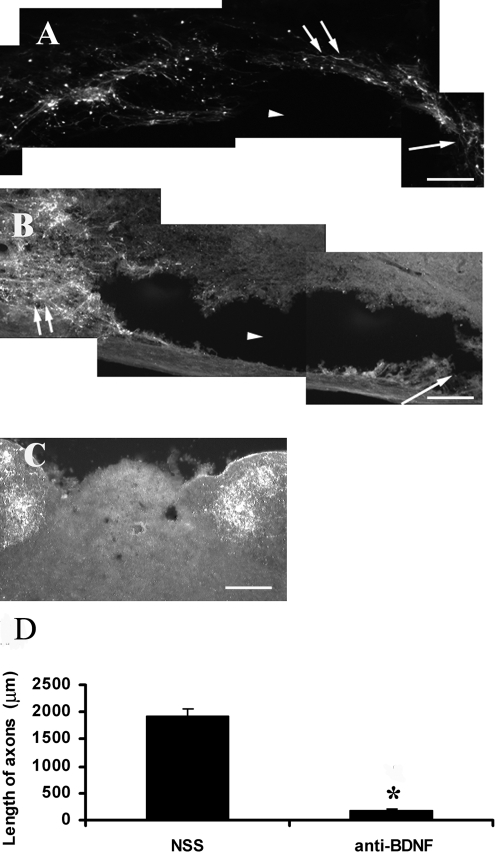
Microphotographs show CTB labeled axons within spinal dorsal column of rats after conditioning sciatic nerve lesion and spinal cord injury.Micrographs (A and B) were captured in the caudal–rostral orientation from left to right. A: In the rats of the NSS treated group, CTB labeled axons (see double arrows) in dorsal column were detected in the spinal cord central and rostral to lesion site along the wall of the cyst resulted from spinal cord injury. B: In the rats of the BDNF antiserum treated group, axons stopped caudal to lesion site (see double arrows) and failed to regenerate into the cyst (see arrow). C: In the rats without spinal cord injury, CTB was transported transganglionically along dorsal column to label the terminals in the gracile nucleus. D: The measurement of the length of CTB positive axons detected beyond the caudal edge of the cysts. The enhanced axonal regeneration by sciatic nerve lesion was substantially blocked by the treatment of the BDNF antiserum. * P<0.01 compared with the NSS group (n = 5/group). Scale bars: 100 µm, applies to A, B and C. Arrowhead: cavity of spinal lesion site. Arrow: rostral side. Double arrows: CTB labeled axons.